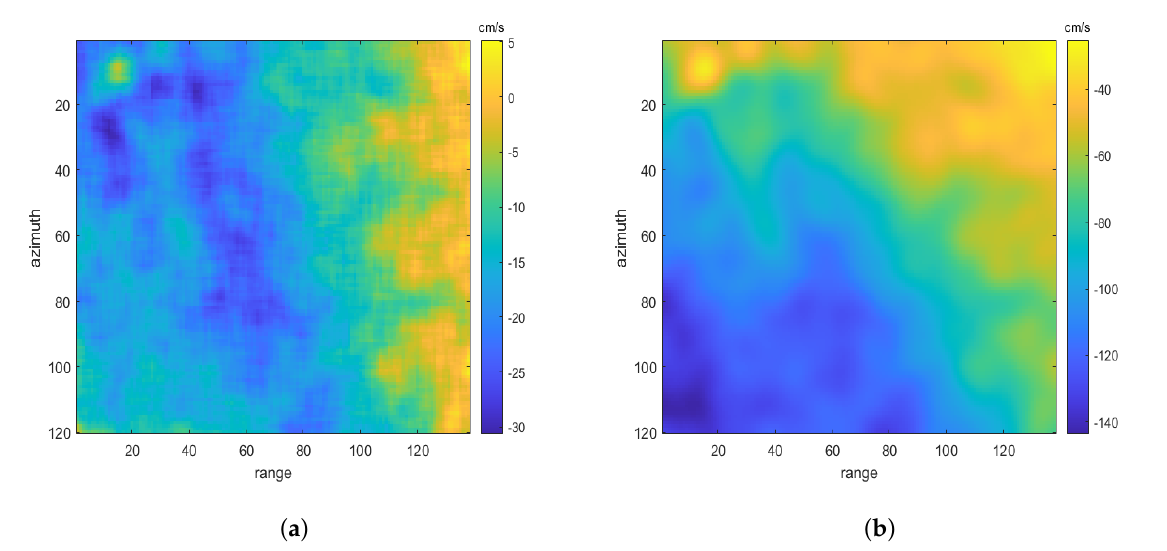
Figure 16. The results retrieved by the Doppler centroid analysis (DCA) method. ( a ) The radial velocities of the ocean surface; ( b ) the ocean current